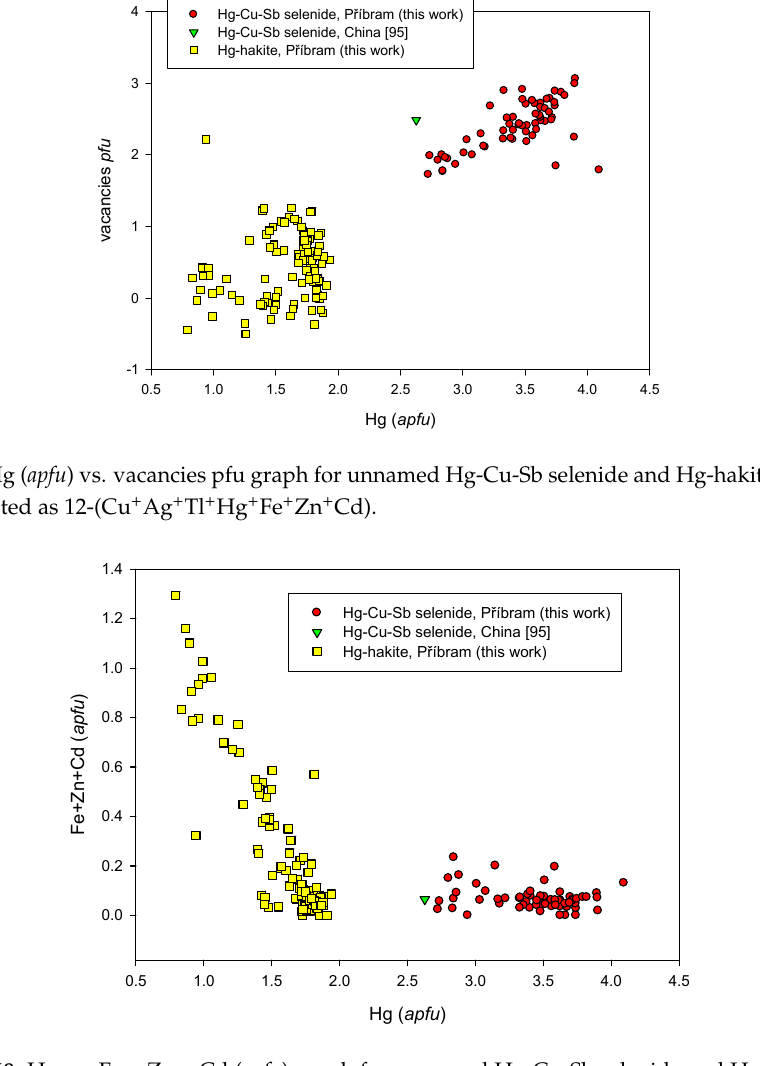
Figure 68. Hg vs. Fe + Zn + Cd ( apfu ) graph for unnamed Hg-Cu-Sb selenide and Hg-hakite.